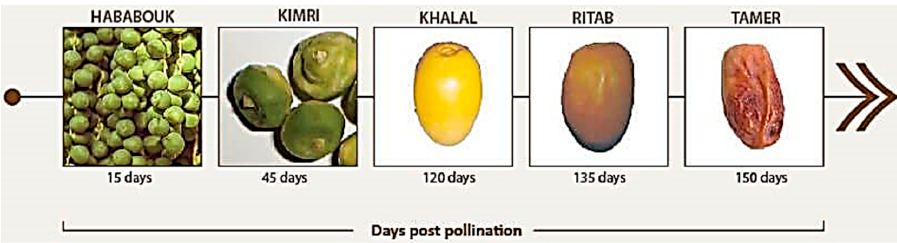
Figure 2. Development of date fruit over time [16].